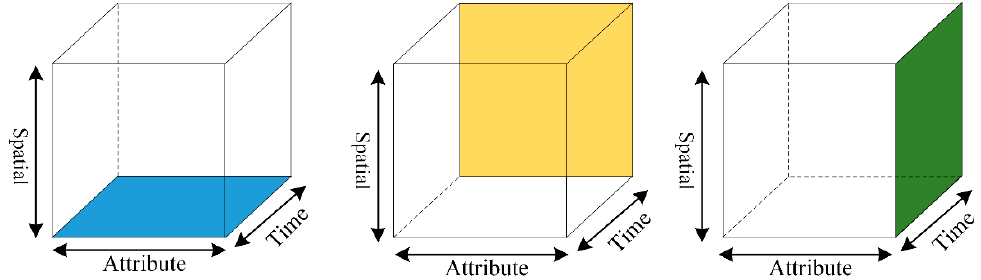
Figure 2. Three types of face aggregation operations on the S × T × A cube.